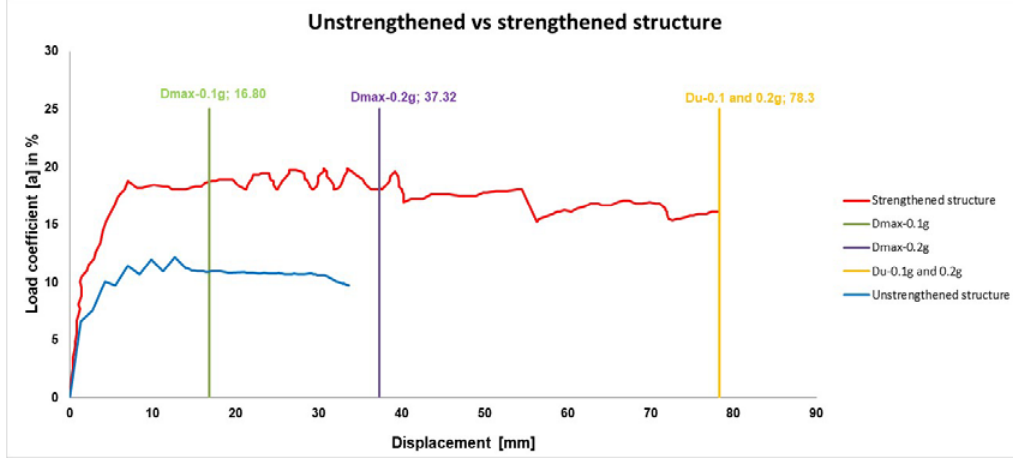
Figure 16. Pushover curves of the unstrengthen and strengthened structures, with performance points for PGA = 0.1 g and PGA = 0.2 g (D max - demand displacement and D u - ultimate capacity displacement).